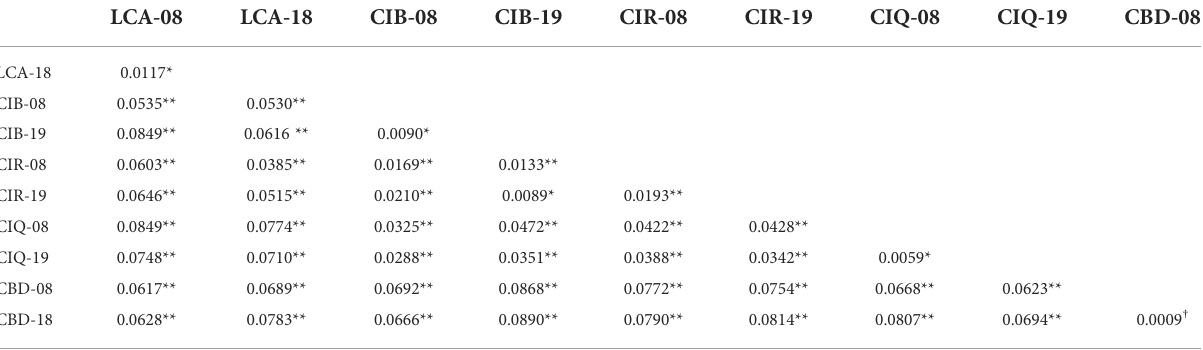
TABLE 3 Pairwise F ST between Macrocystis pyrifera samples with G-test of signi fi cance computed in GENEPOP v. 4.7.5. .